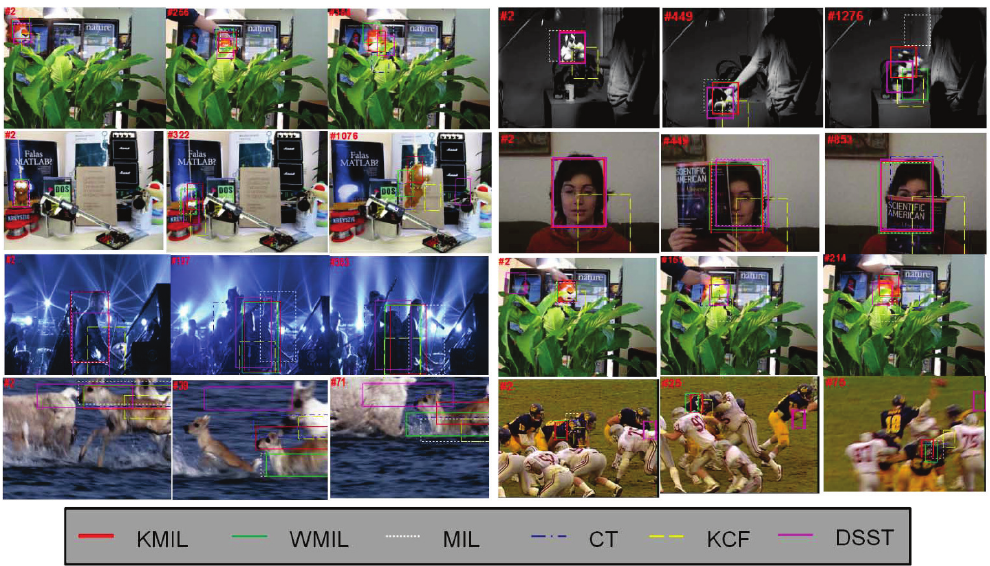
Figure 2. The illustration of the tracking locations on the sequences: “Deer”, “Tiger2”, “Faceocc2”, “Sylvester”, “Football1”, “Shaking”, “Tiger1”,